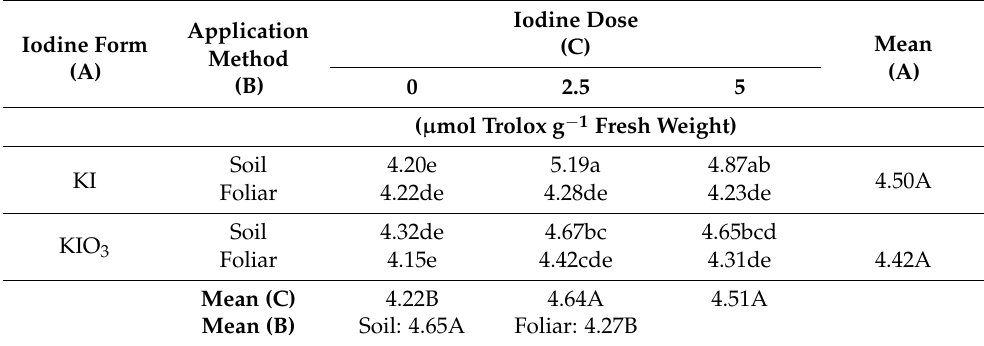
Table 6. Total antioxidant capacity (TAC DPPH) in rye plants depending on I dose, form, and method of application.